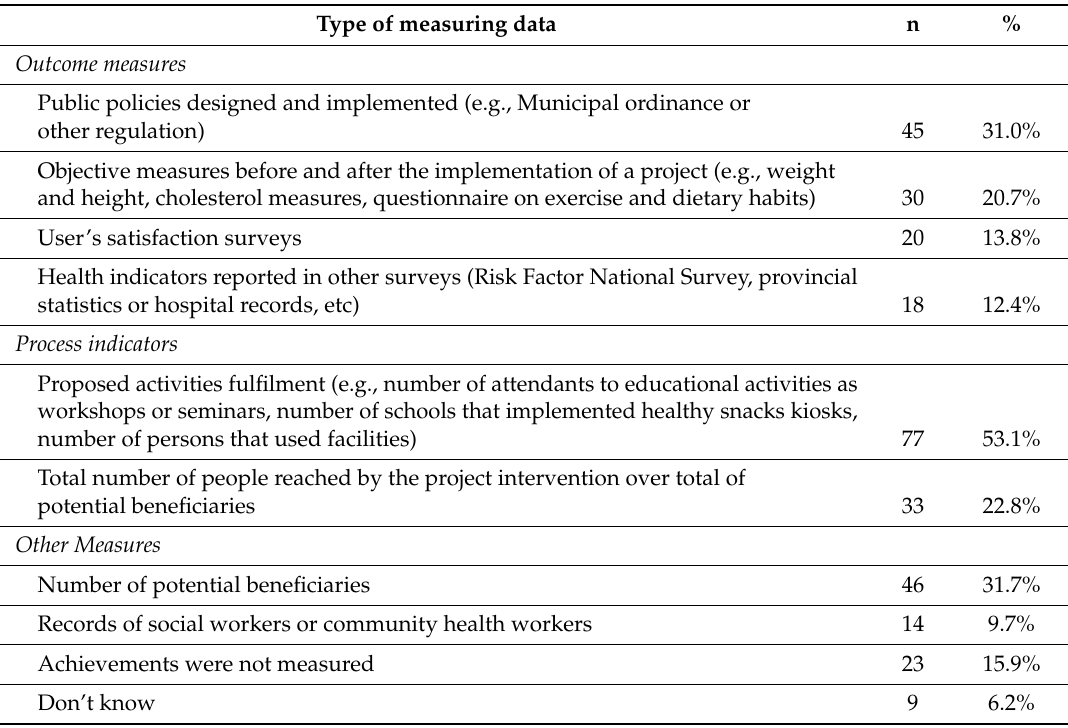
Table 4. Outcomes and process indicators used in local projects from survey respondents (n =